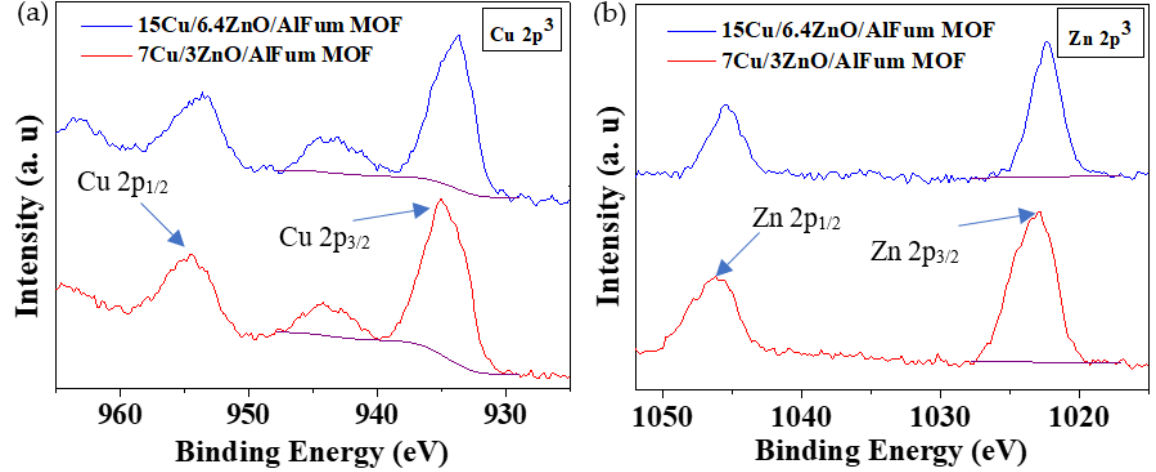
Figure 5. XPS spectra ( a ) Cu 2p and ( b ) Zn 2p of 7Cu/3ZnO/AlFum MOF and 15Cu/6.4ZnO/AlFum MOF catalysts.